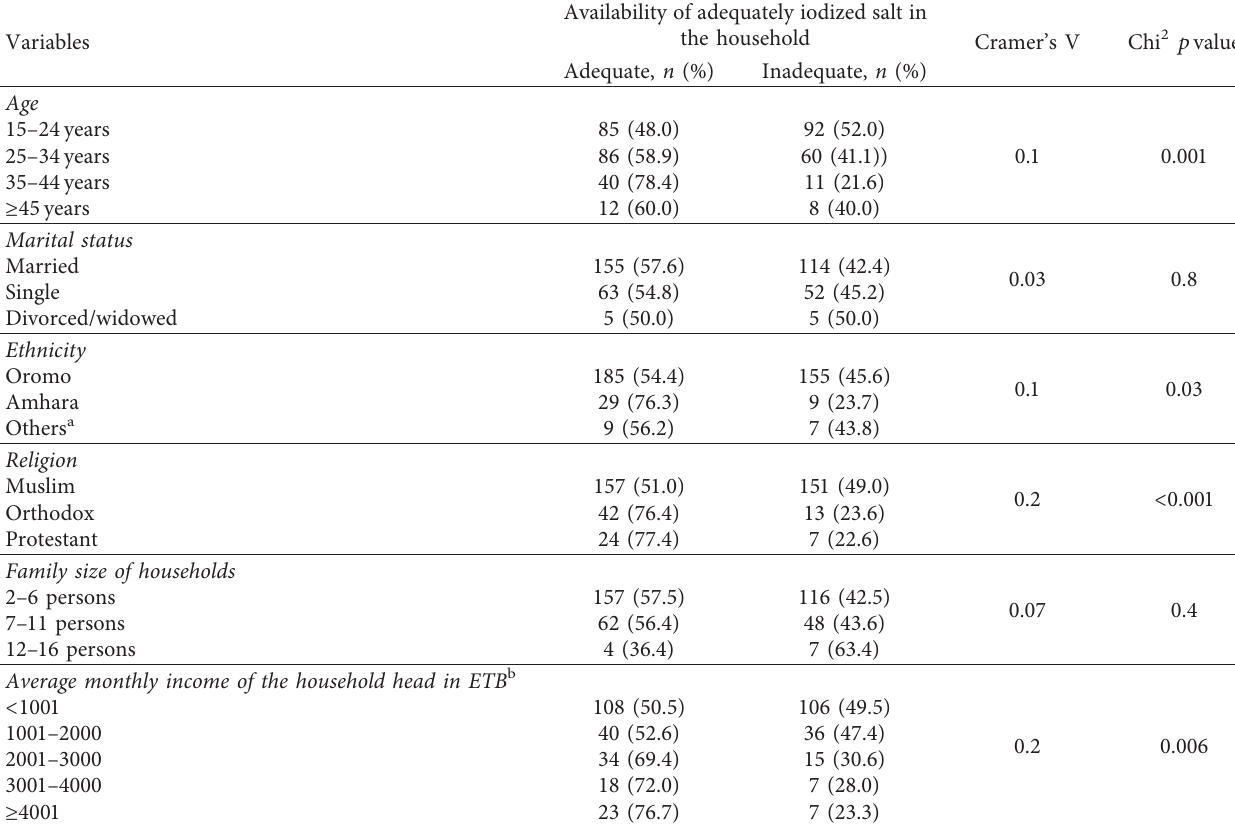
Table 1: Sociodemographic characteristics of respondents in Kore Town, Southeast Ethiopia,